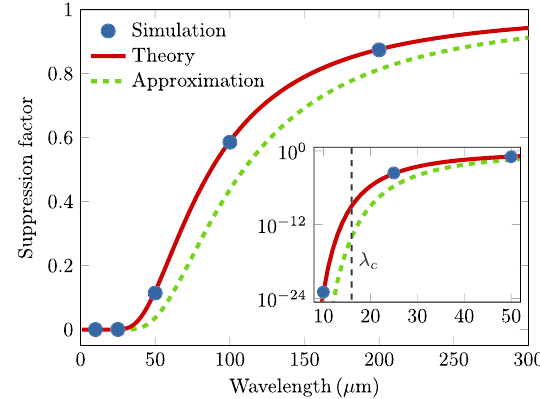
FIG. 4. Analytical calculations and numerical simulations (blue dots) of the suppression S for initial density modulations. The theory curve (solid red line) is calculated for the full term in Eq. (13), and the approximation (dashed green line) is calculated p ffiffiffiffiffiffiffiffiffiffiffi (cid:1) R " . The inset shows the wavelength range below for (cid:3) (cid:6) 0 0 51 52 (cid:5) m on a logarithmic scale including the cutoff wavelength N (cid:6) 10 9 (cid:10) c calculated for